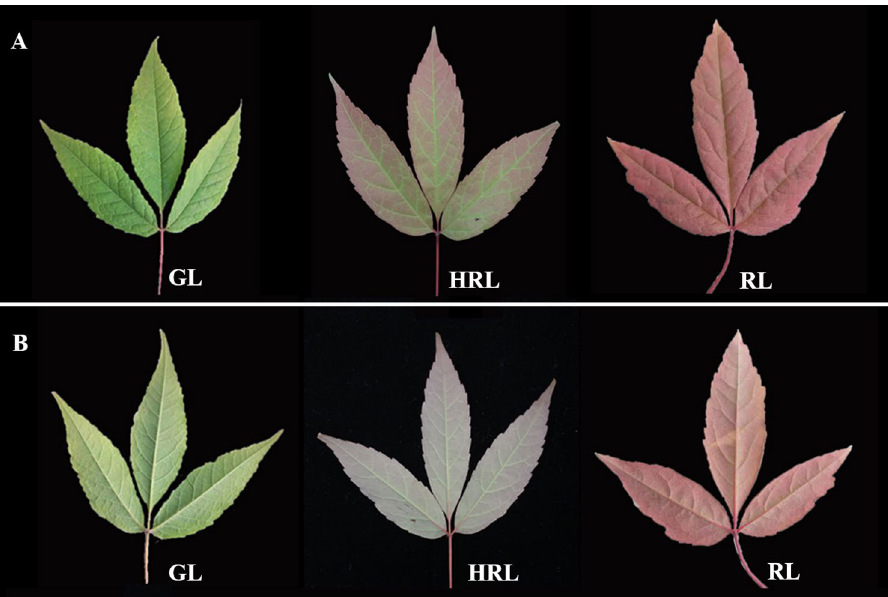
Figure 1. Phenotypes of A. mandshuricum . Green (GL), half red leaf (HRL), red leaves (RL) on front ( A ) and back ( B